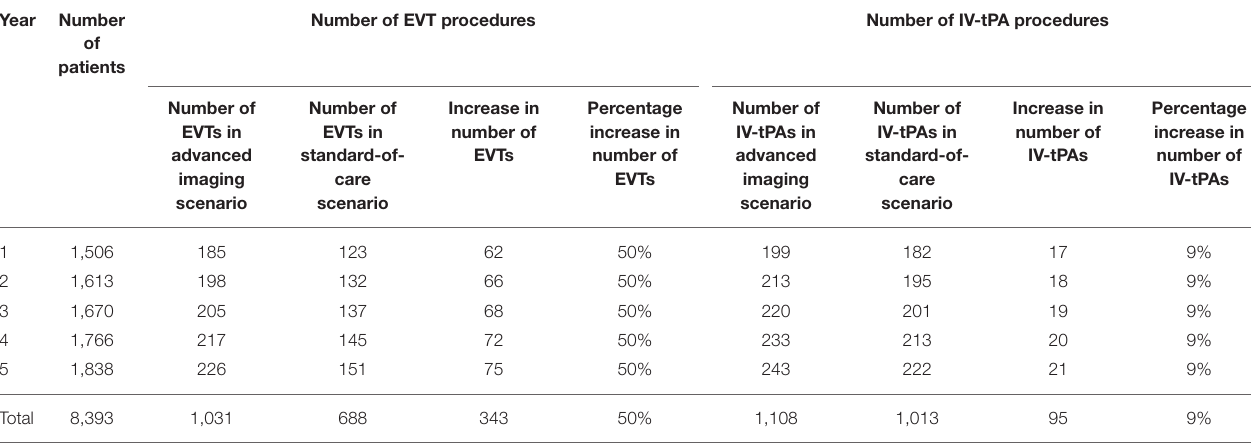
TABLE 4 | Estimated number of EVT and IV-tPA procedures in the advanced CTAP imaging and standard-of-care strategies for the 5-year period. Year Number